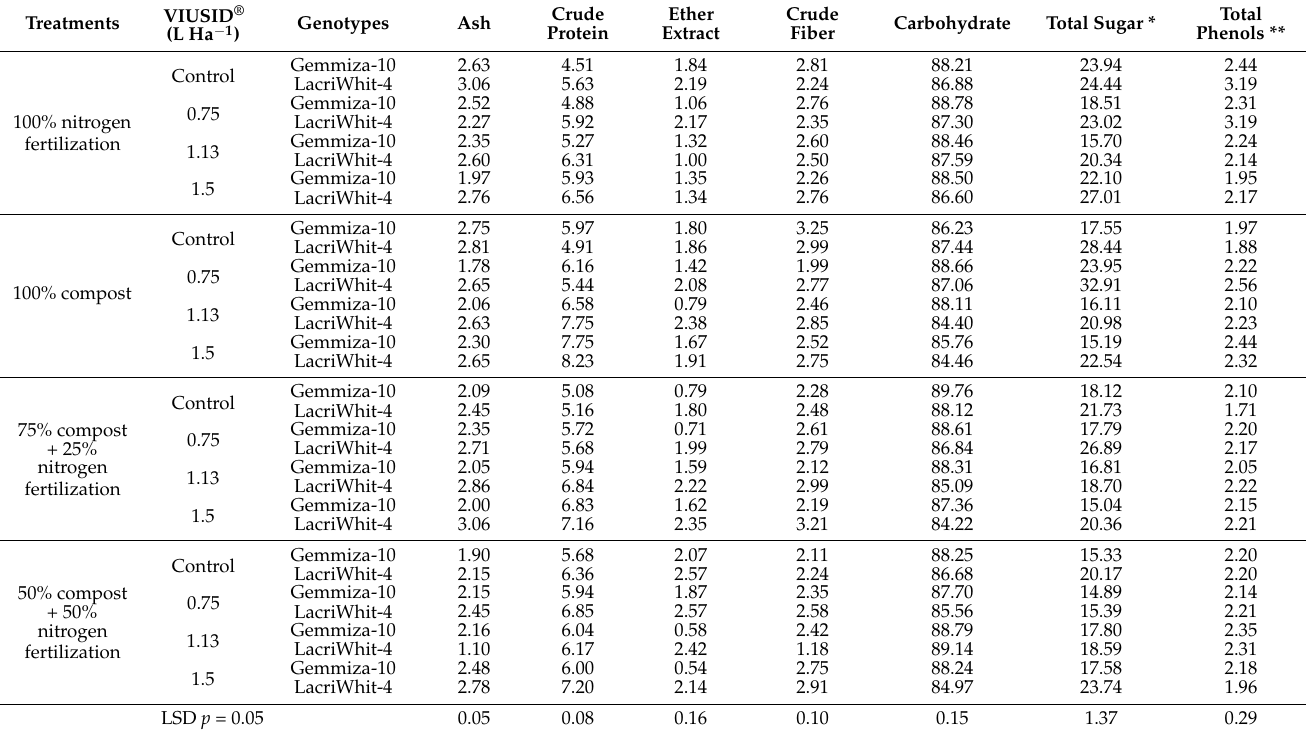
Table 7. Effect of different levels of compost, foliar application of VIUSID ® agro and two wheat cultivars on chemical composition of grain (g/100